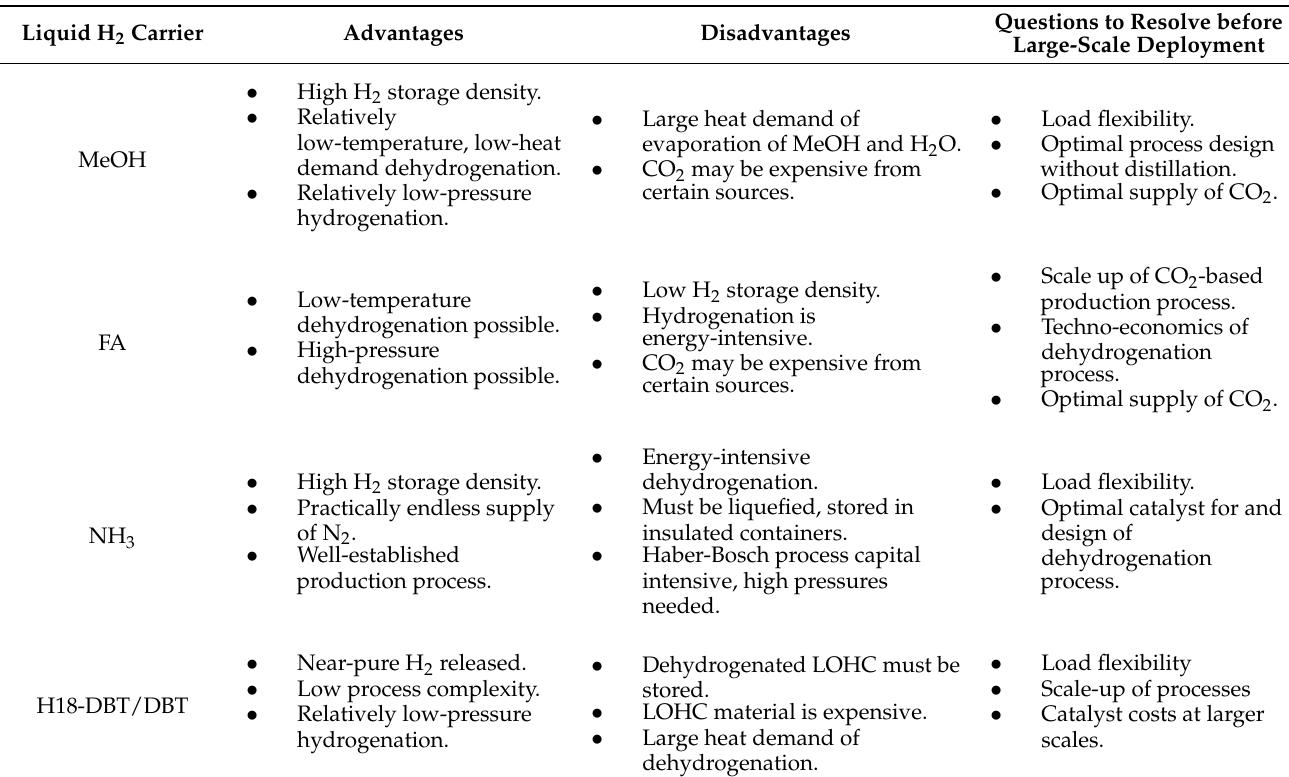
Table 3. Summary of advantages, disadvantages and main questions left to be answered before large-scale employment of the considered liquid H 2